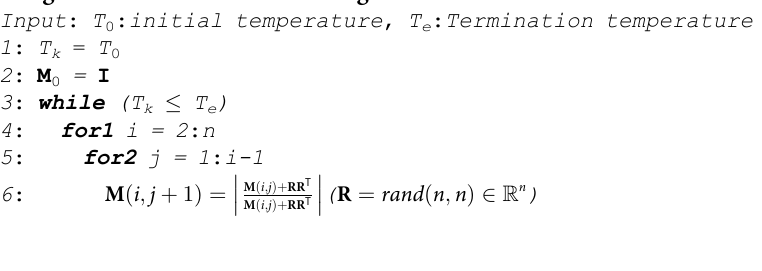
Algorithm 3 . The solution of weight matrix M.